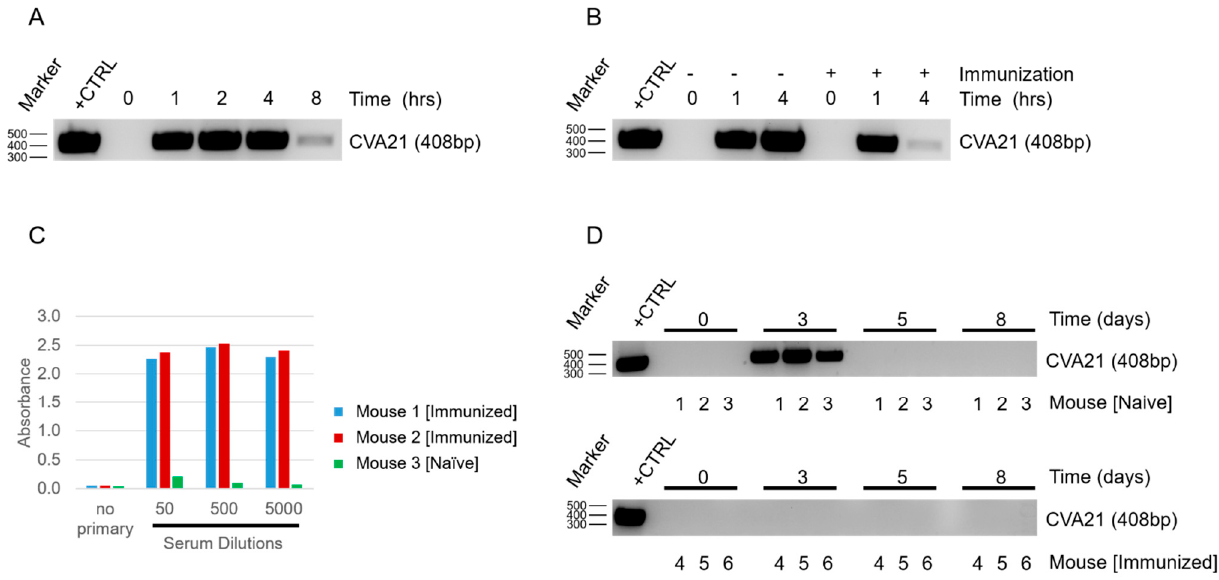
Figure 2. Response to systemic and intratumoral CVA21 exposure in a murine model system. ( A ) RT-PCR time course of CVA21 systemically delivered IP and extracted from the blood of naïve mice. Purified CVA21 stock was used as a positive control for comparison ( A , B , D ). ( B ) RT-PCR time course comparison of CVA21 systemically delivered IP and extracted from the blood of naïve or immunized mice. ( C ) ELISA test for CVA21 antibodies in the serum of naïve and immunized mice. ( D ) RT-PCR time course of CVA21 in the blood following IT injection of naïve and immunized mice (3 mice/cohort).